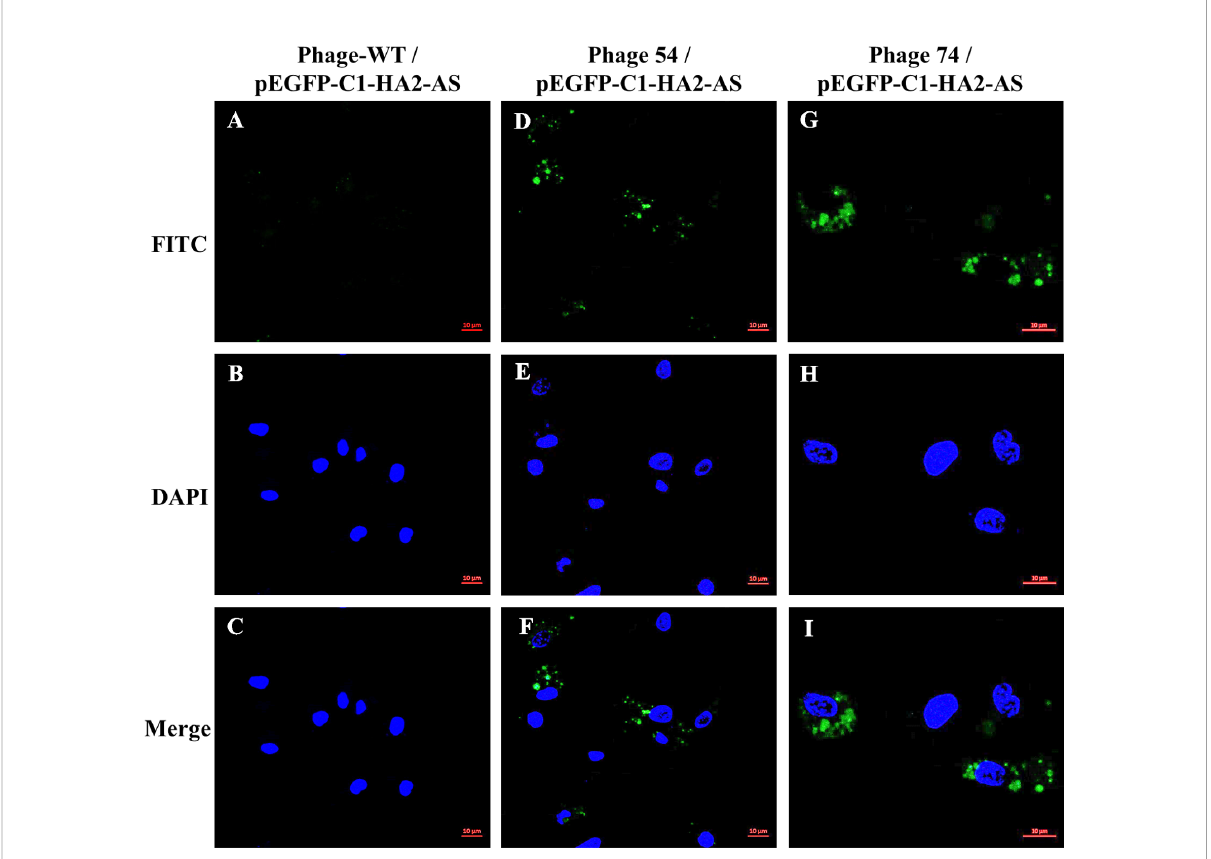
FIGURE 5 HA2 expression in dendritic cells (DC) mediated by phage T7-WT, phage 54 and phage 74 was analyzed by confocal laser microscopy. Three phage particles encapsulating pEGFP-C1-HA2-AS were incubated with chicken bone marrow DC, respectively. The HA2 protein expressed within DC was revealed by anti-AIV H5 polyclonal primary antibody and FITC conjugated goat anti-chicken secondary antibody as shown in green (A, D, G) ; nuclei were identi fi ed by DAPI staining as shown in blue (B, E, H) ; and the relative position of the HA2 protein and nuclei was showed in merged pictures (C, F, I)